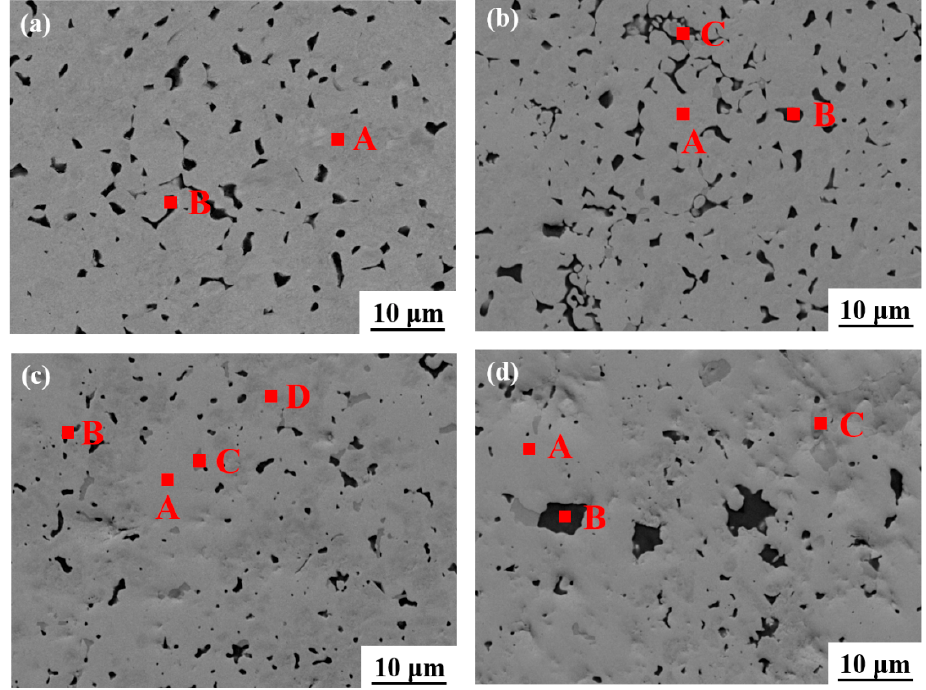
Figure 2. SEM images of the sintered W-1.5 Y-x Hf, where x is ( a ) 0, ( b ) 10, ( c ) 20, and ( d )